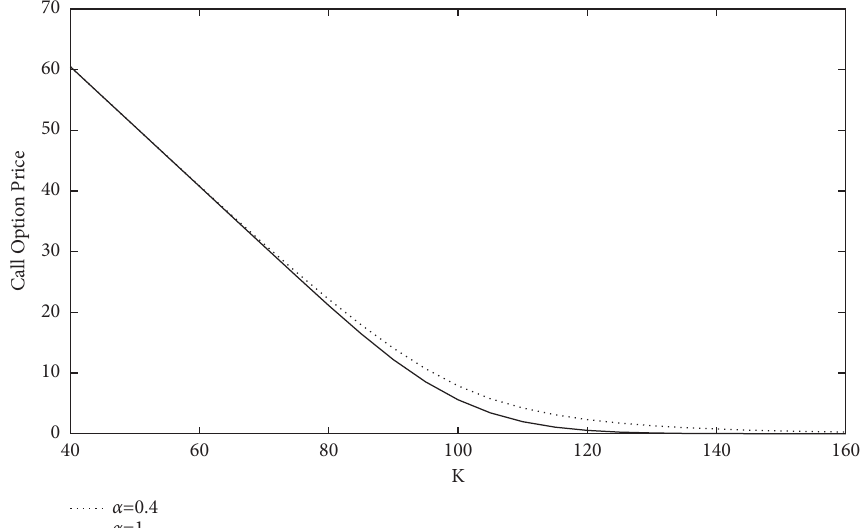
Figure 2: The Call option price with different α . Here, r � 0 . 05, σ � 0 . 25, S stochastic simulation, and the result is obtained by simulating 50,000 times.